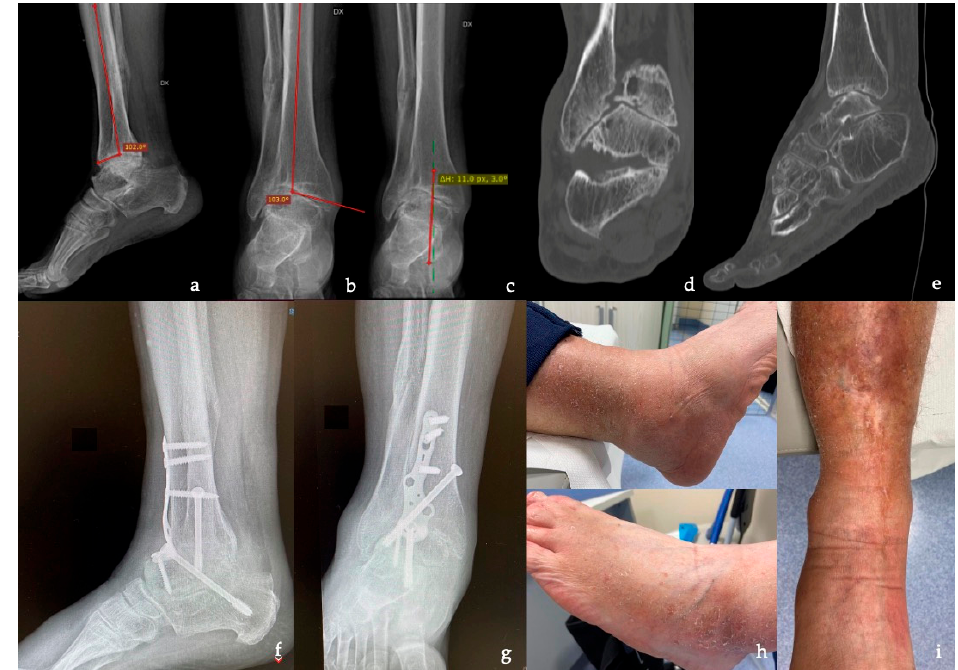
Figure 2. A 55-year-old man with severe osteoarthritis (OA) and deformity of the right ankle and a history of rheumatoid arthritis, diabetes mellitus, and venous insufficiency. ( a – c ) Pre-operative X-ray in the lateral and anteroposterior view. ( d , e ) Pre-operative CT showing severe OA of the TT joint. ( f , g ) Lateral and anteroposterior X-ray at 3 months of follow-up from tibiotalocalcaneal (TTC) arthrodesis with the anterior plate showing complete bone union. ( h , i ) Clinical image of the soft tissue condition.